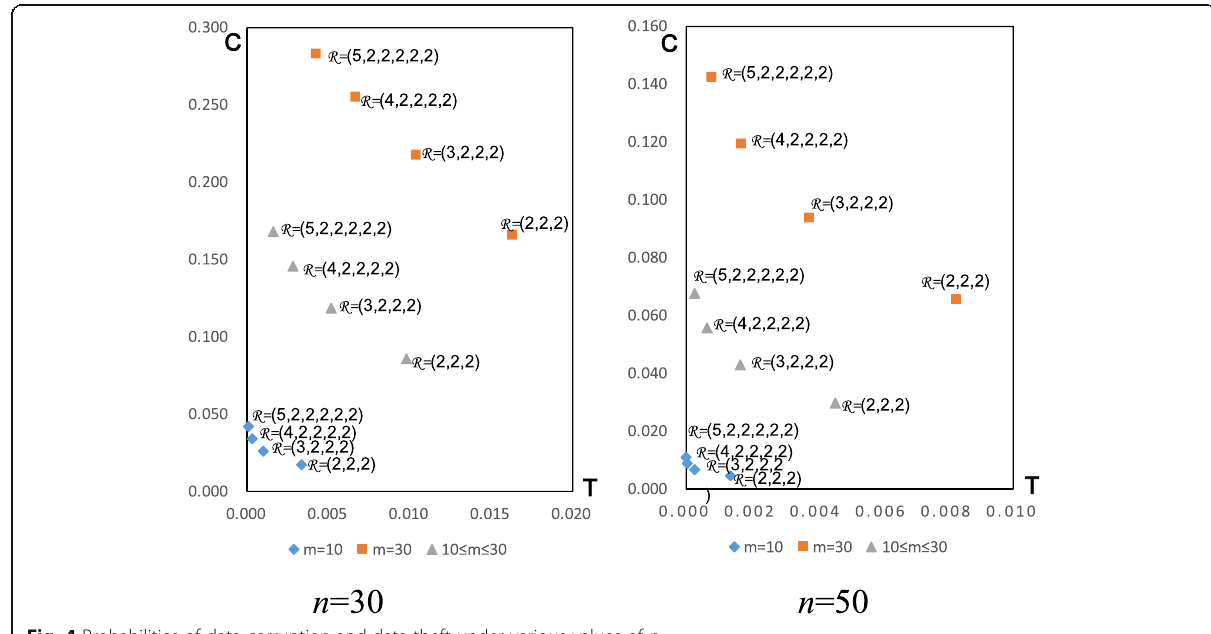
Fig. 4 Probabilities of data corruption and data theft under various values of n